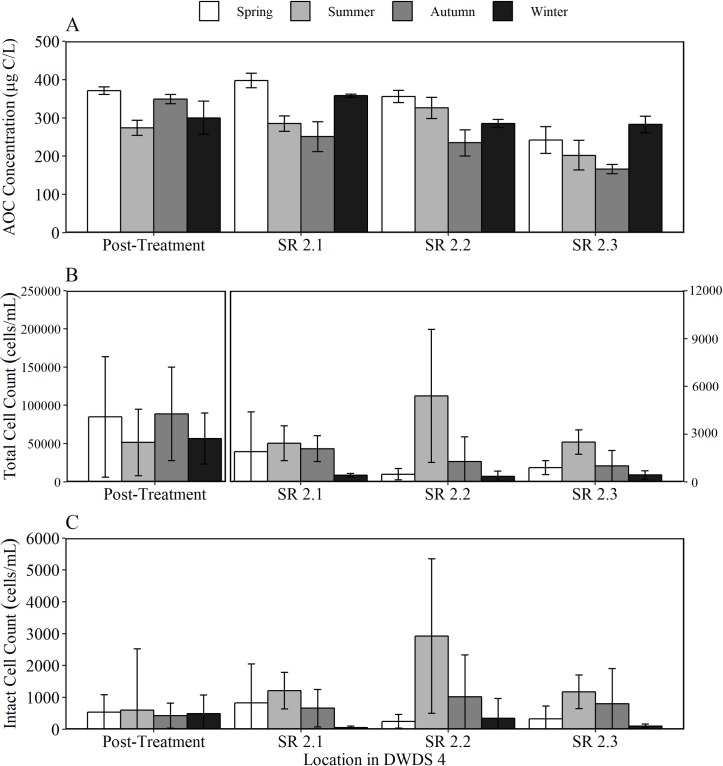
Seasonal water quality data for DWDS 2.Variation in the mean a) AOC concentration b) total cell counts (TCC) and c) intact cell counts (ICC) in post-treated water and three service reservoirs (SR) within the DWDS. Nb different y-axis scale for each parameter, and different y axis scales used in Fig 9, Fig 10 and Fig 11. Panel B of Fig 9 has two y-axis so that both the TCC within post-treated water, and each of the SR, are visible. Data was split into spring, summer, autumn and winter seasons based on monthly averages in temperature.